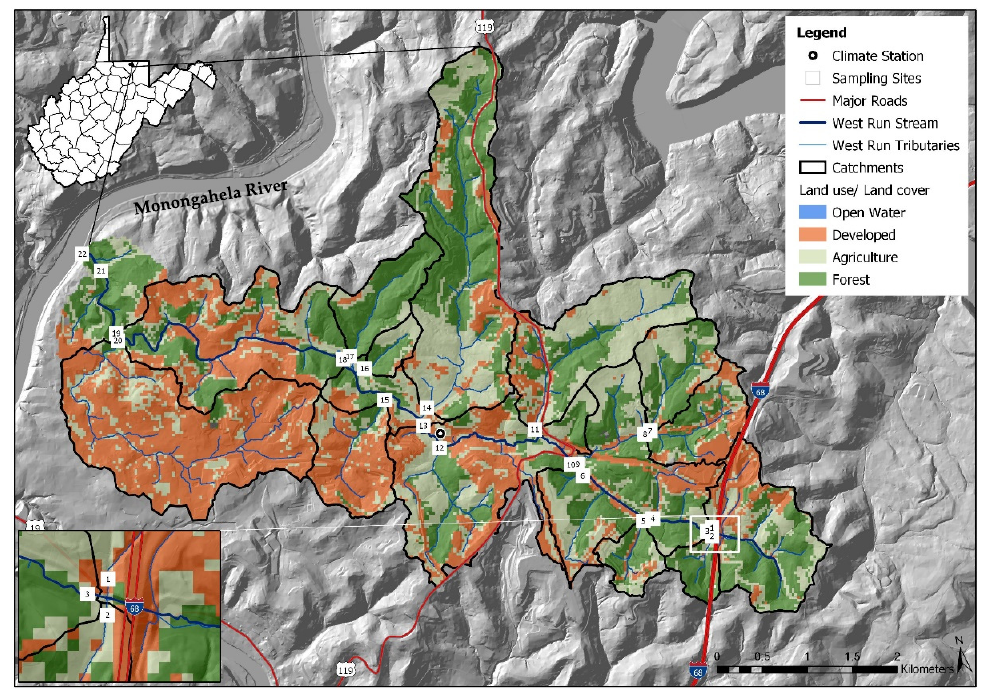
Figure 1. Monitoring site locations ( n = 22) and land use cover, in West Run Watershed, Morgantown (Latitude: 39.629524, Longitude: − 79.955894, WV, USA).